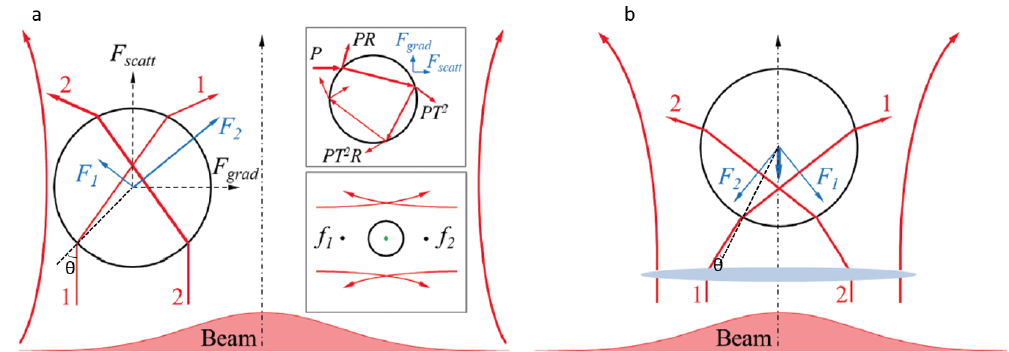
Figure 1. The scattering and gradient forces acting on a dielectric particle in the ray optics regime, arising from a free space ( a ) and a tightly focussed ( b ) Gaussian beam. In the subplot ( a ) the forces push the particle towards the centre of the beam and along the direction of propagation, whereas in ( b ) the forces drag the particle towards the focus of the beam. The upper panel in subplot ( a ) shows the proposed geometry for calculating the forces using Fresnel coefficients. The bottom panel shows trapping using counter-propagating beams with the same characteristics so that the scattering forces cancel each other to achieve a stable trap. Figure reproduced with permission from